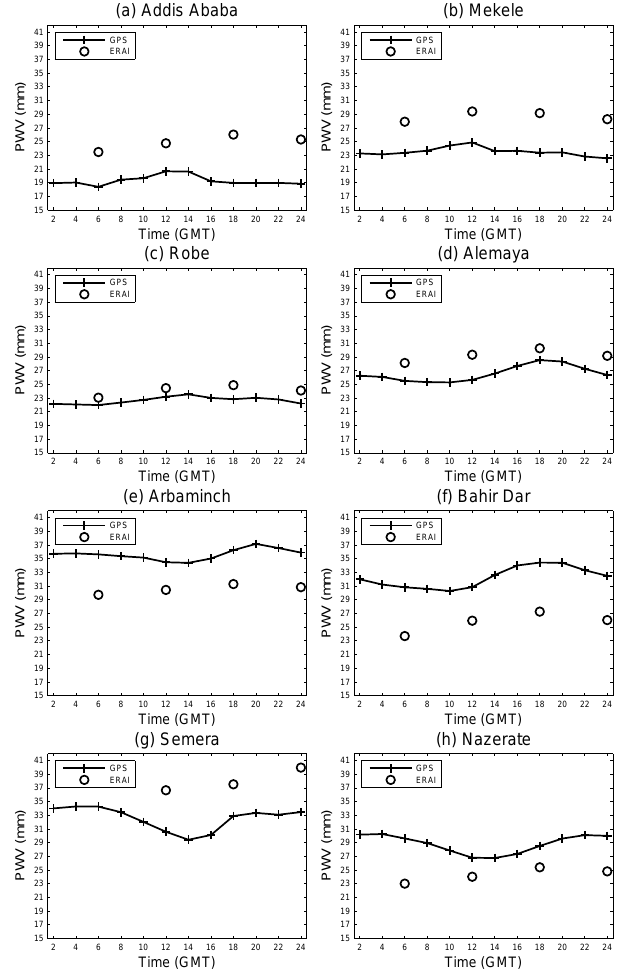
Figure 10. The diurnal cycles of GPS and ERA-Interim PWV at all GPS ground receiver sites during summer.